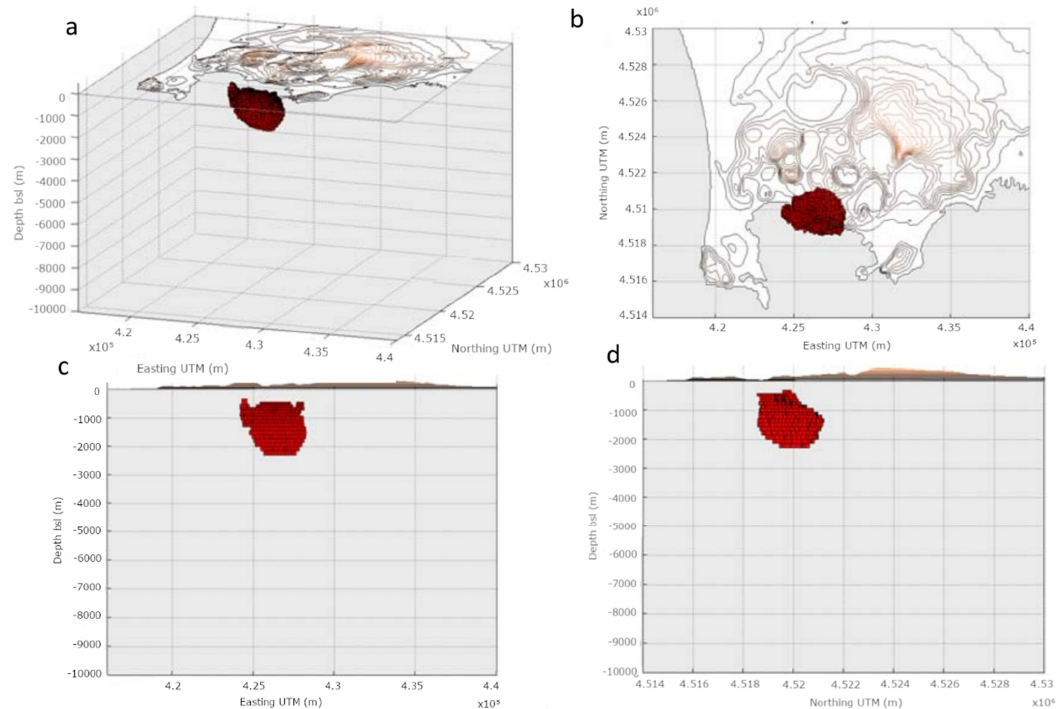
Figure 8. Source location, depth and shape for deflation period of 1999–2000. ( a ) 3D perspective; ( b ) map view of source below Campi Flegrei caldera; ( c ) EW vertical profile; ( d ) NS vertical profile